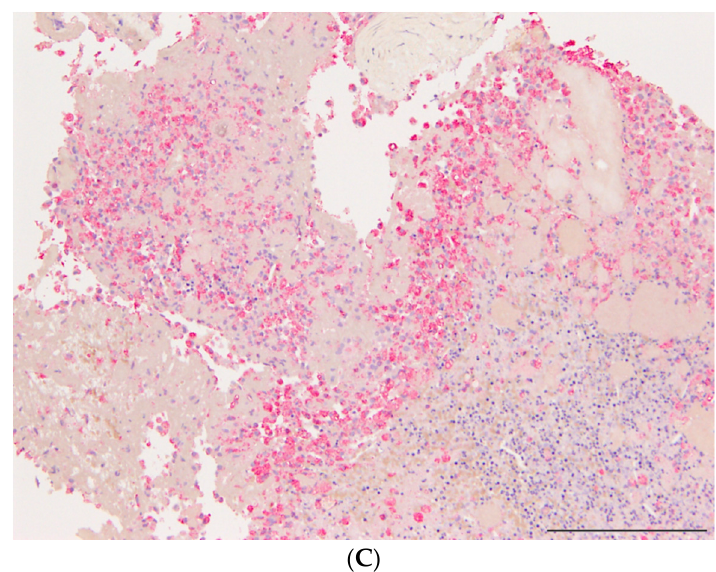
Figure 4. Examples of histological examined carotid plaques. ( A ) Example of a carotid plaque, stained H and E. The plaque is obliterating the lumen but shows mainly vessel wall fibrosis. No blood clot, no granulocytic or cap macrophage infiltration or plaque rupture is seen. The plaque has been regarded as “not active”. Bar size: 1 mm; ( B ) neovascularization and clustered lymphocyte infiltration at the border between carotid plaque and adventitia (H and E stain). Bar size: 100 µm; and ( C ) immunohistochemical staining of macrophages (red), infiltrating and resorbing a blood clot at the cap of an “active” carotid plaque. Monoclonal antibody KiM1P, visualized by neufuchsin. Bar size: 200 µm.